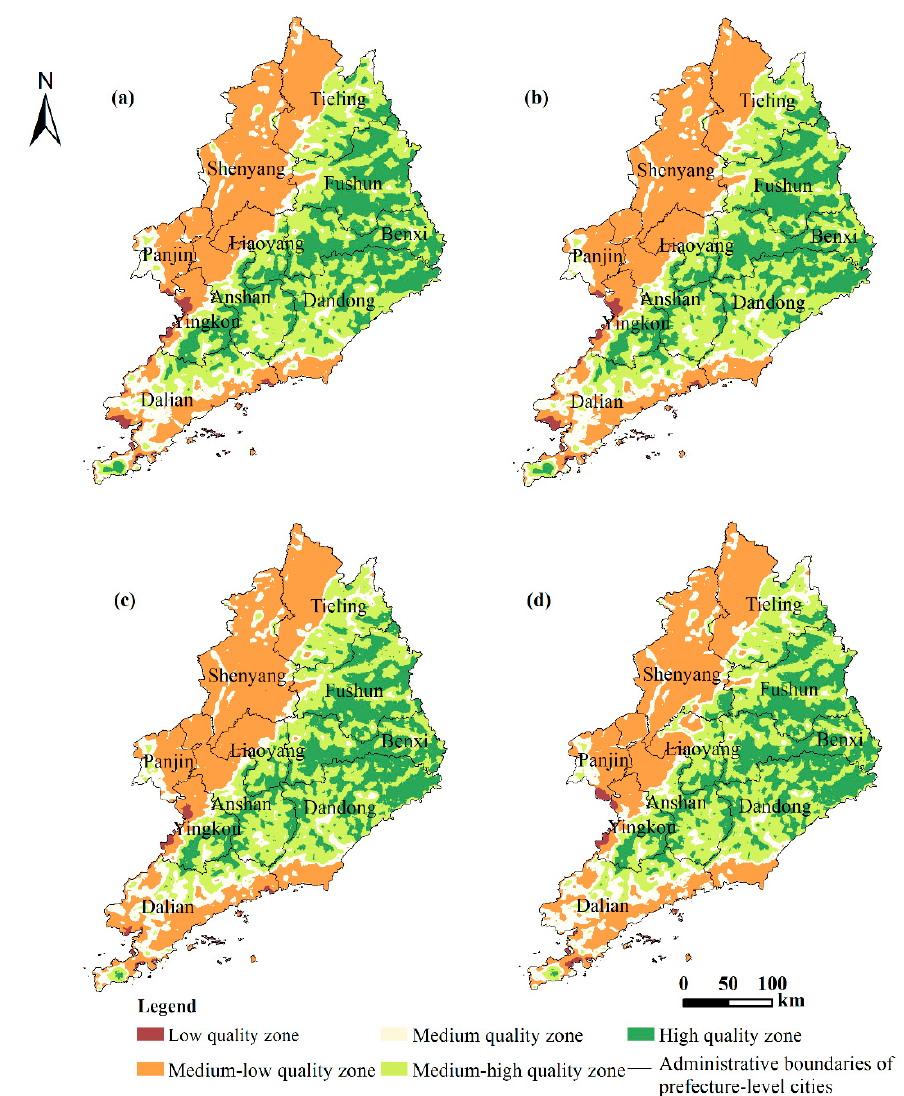
Figure 4. Distribution of the eco-environmental quality index in the central and southern Liaoning urban agglomeration 1990–2018. ( a ) 1990; ( b ) 2000; ( c ) 2010; ( d ) 2018.